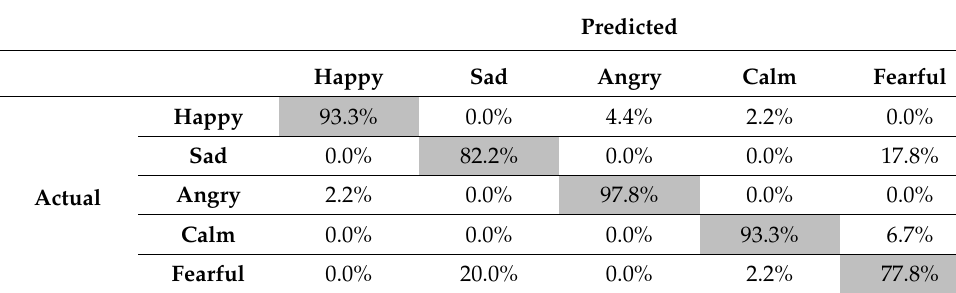
Table 6. The confusion matrix of the best sound adjustment